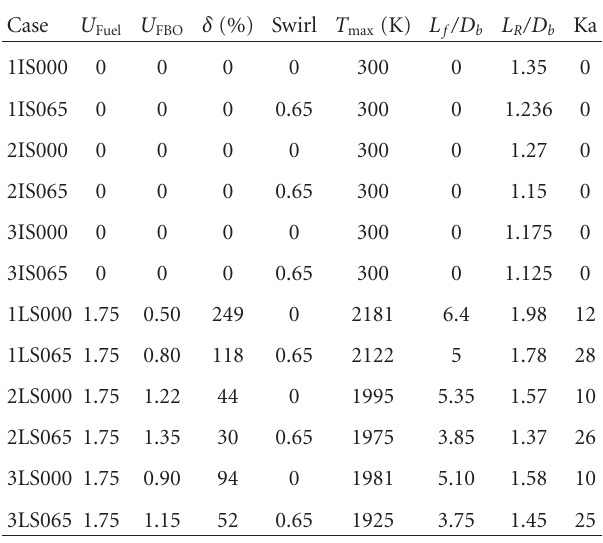
Table 1: Investigated premixer/burner conditions.